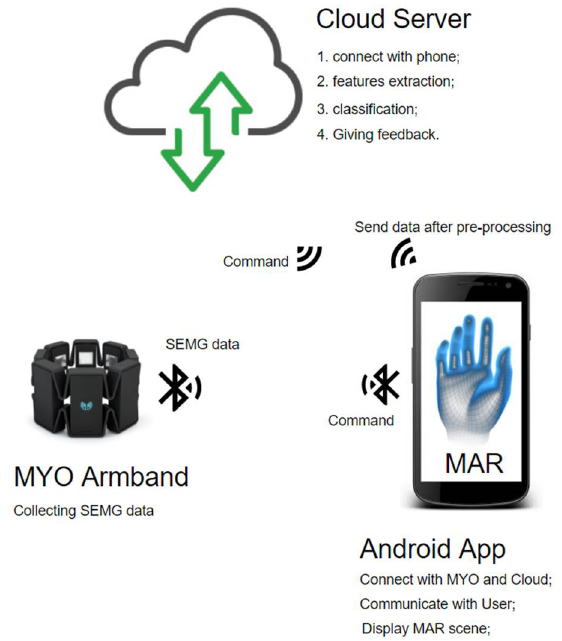
Figure 10. The designed mirror therapy system structure diagram.